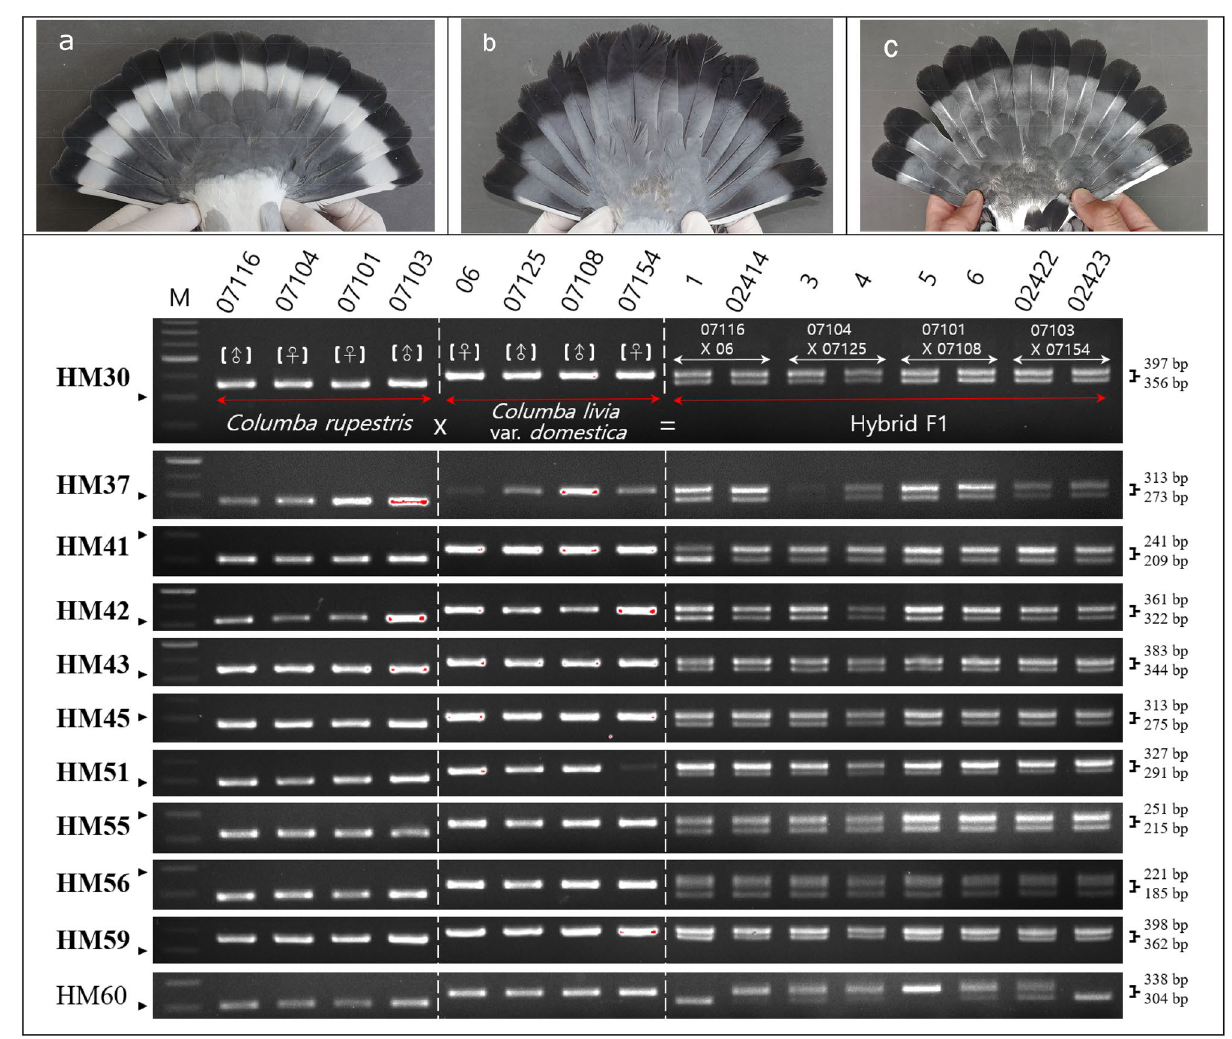
Figure 1. Testing of 11 InDel regions to develop the markers of hybridization between two wild populations ( Columba rupestris and C. livia var . domestica ) and their hybrid using agarose gel electrophoresis. The names of accepted markers are shown in bold. Black arrows indicate 300 bp. Representative phenotypes (i.e., white band in tail feathers) of pigeons. Phenotypes are shown for ( a ) a hill pigeon ( C. rupestris ), ( b ) a feral pigeon (